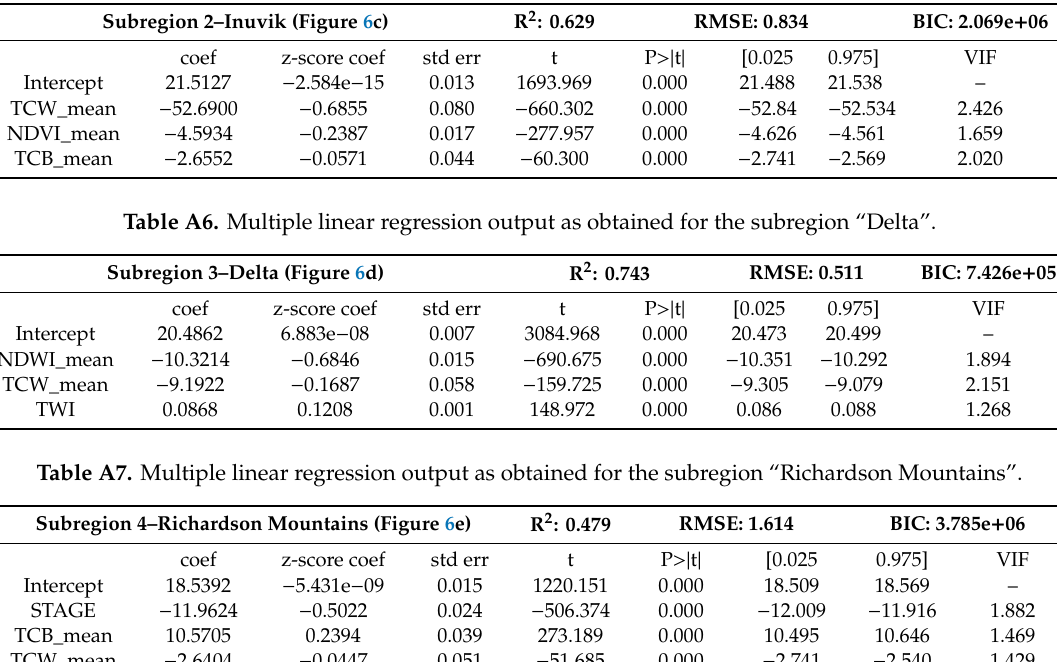
Table A5. Multiple linear regression output as obtained for the subregion “Inuvik”.